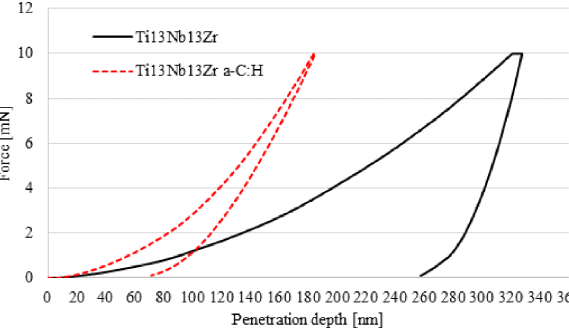
Figure 5: Load – penetration depth curves from indentation tests